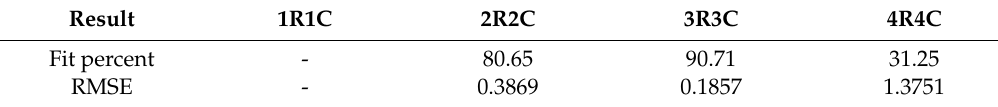
Table 9. Sixty-minute prediction results for experiment B. Table 8. Thirty-minute prediction results for experiment B.